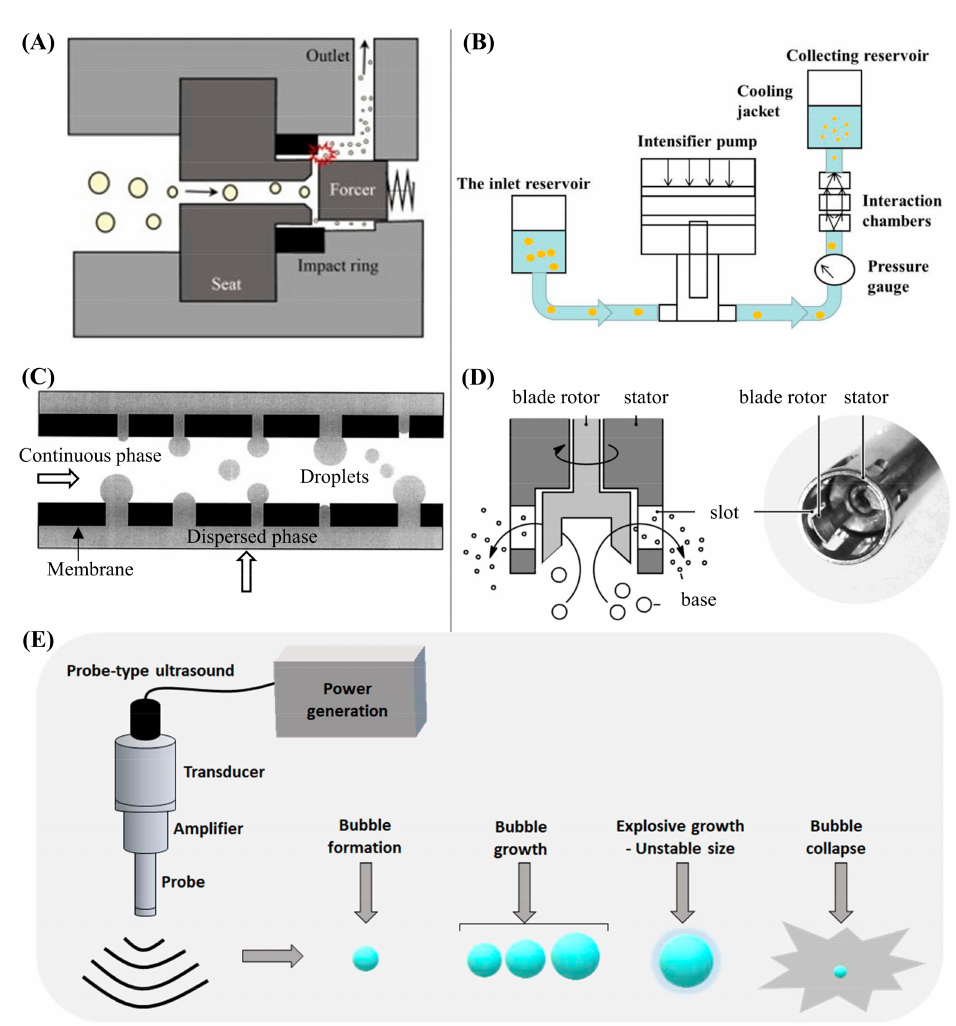
Figure 3. Illustrations of high-energy methods. ( A ) High-pressure homogenization (Reproduced with permission from Ref. [38]. Copyright 2016 Elsevier); ( B ) High-pressure microfluidization Repro- duced with permission from Ref. [39]. Copyright 2020 Elsevier); ( C ) Membrane emulsification [40]; ( D ) Rotor-stator homogenization (Reproduced with permission from Ref. [41]. Copyright 2016 John Wiley and Sons); ( E ) Ultrasonic emulsification (Reproduced with permission from Ref. [42]. Copyright 2020